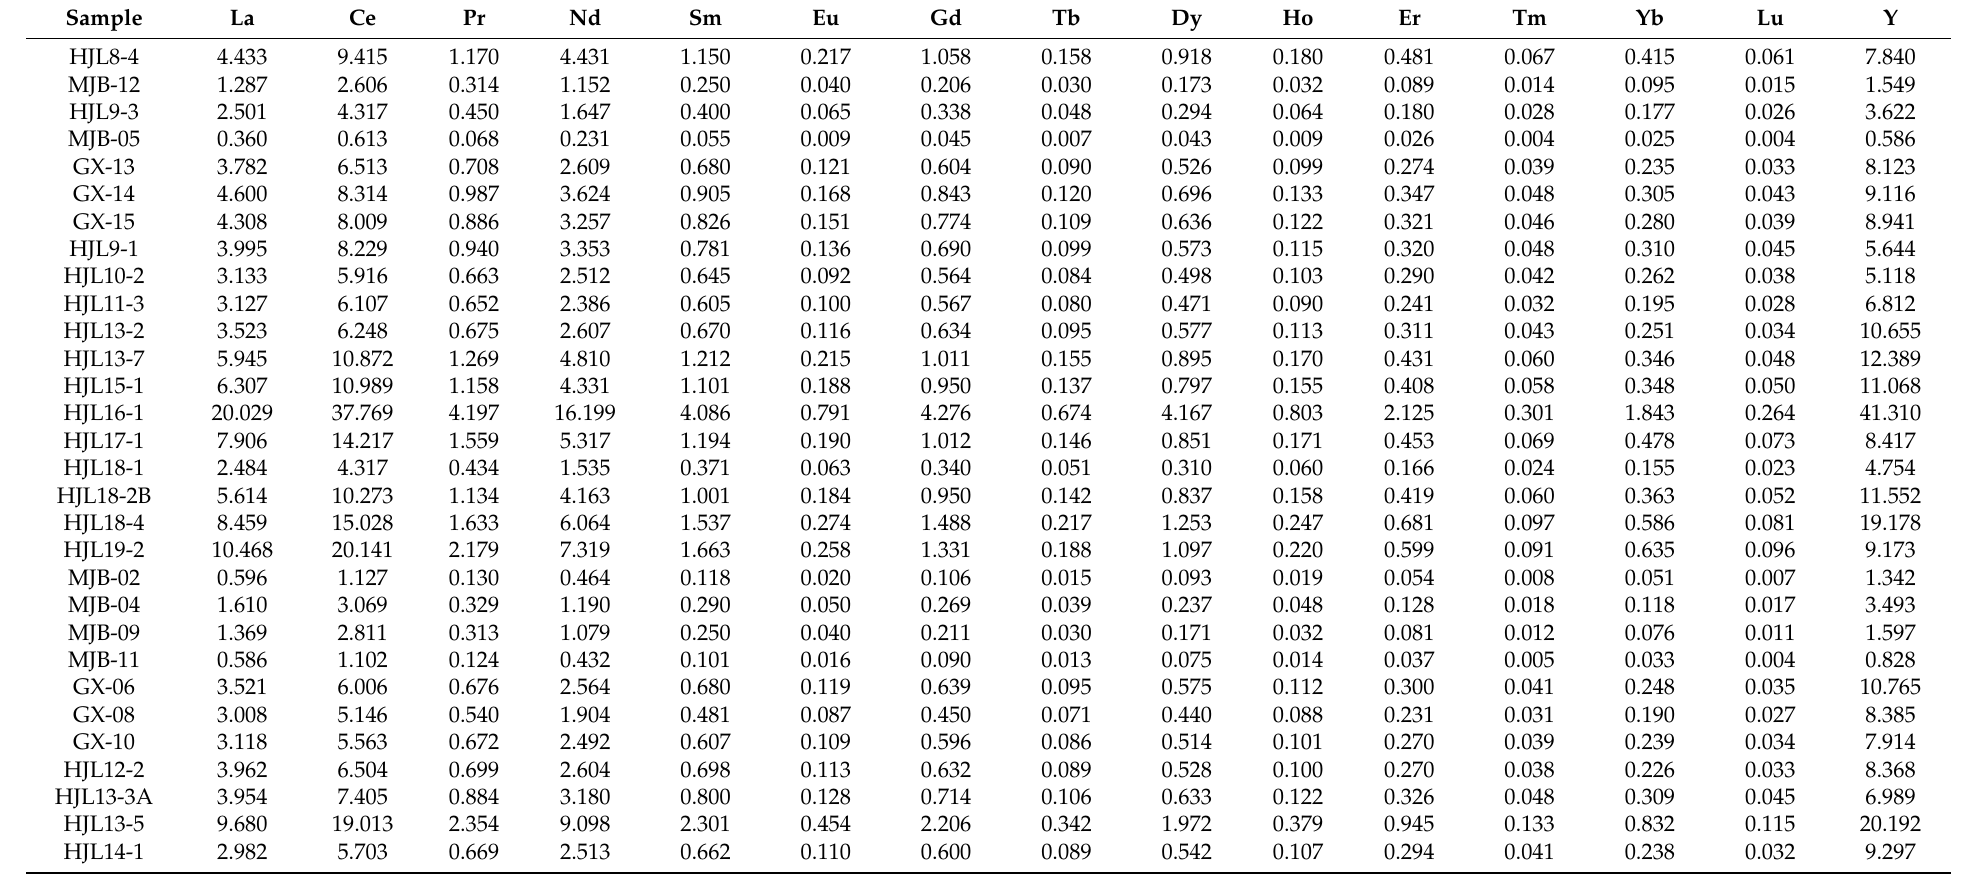
Table 2. REE composition (ppm) of the carbonate of the